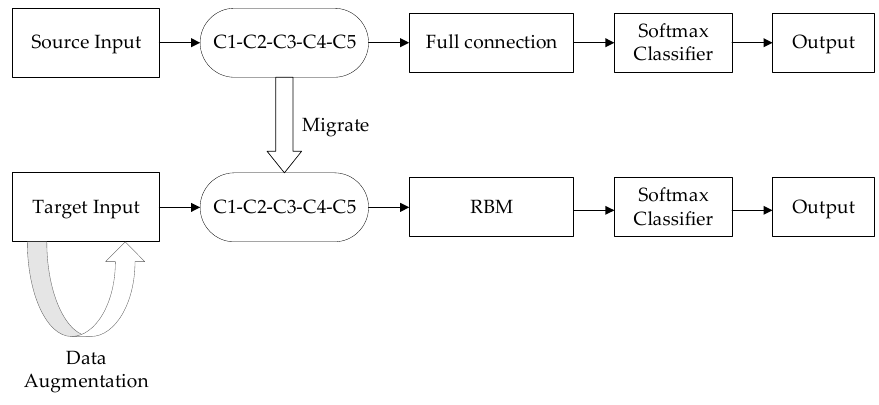
Figure 1. Transfer of TLCNN-RBM model.